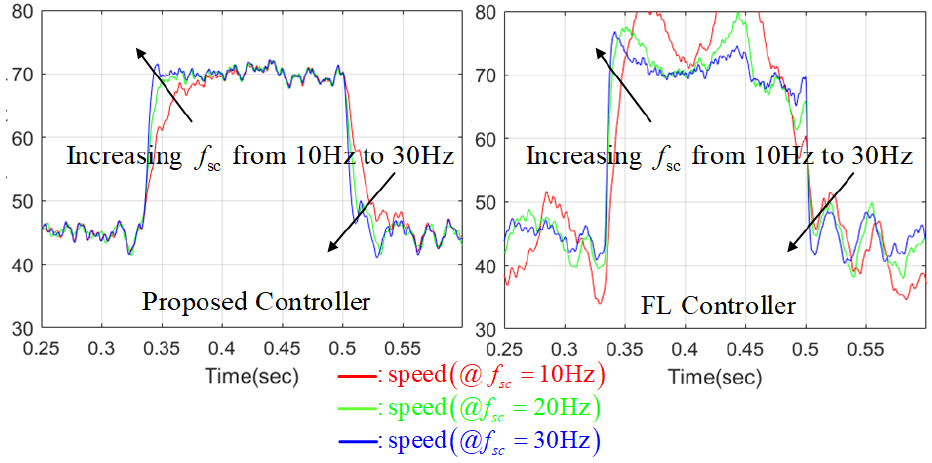
Figure 7. Speed tracking performance changes for various cut-off frequencies as f sc = 10, 20, 30